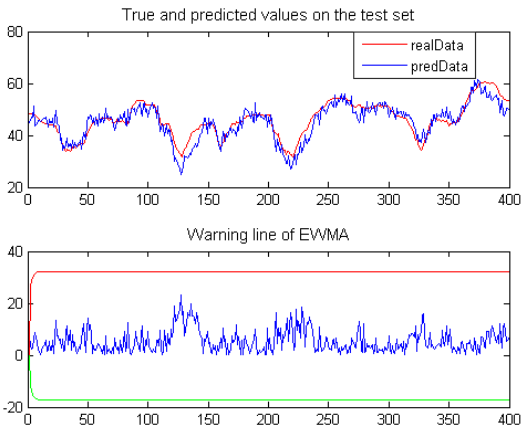
Figure 4. Early warning of models on test set.